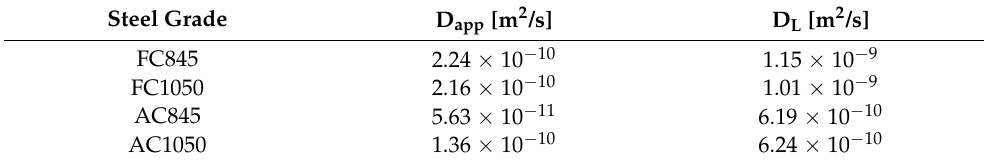
Figure 8. Evolution of D app with J c for the annealed and normalized 42CrMo4 grades. Table 7. D app (first transient) and D L of quenched and tempered 42CrMo4 grades.